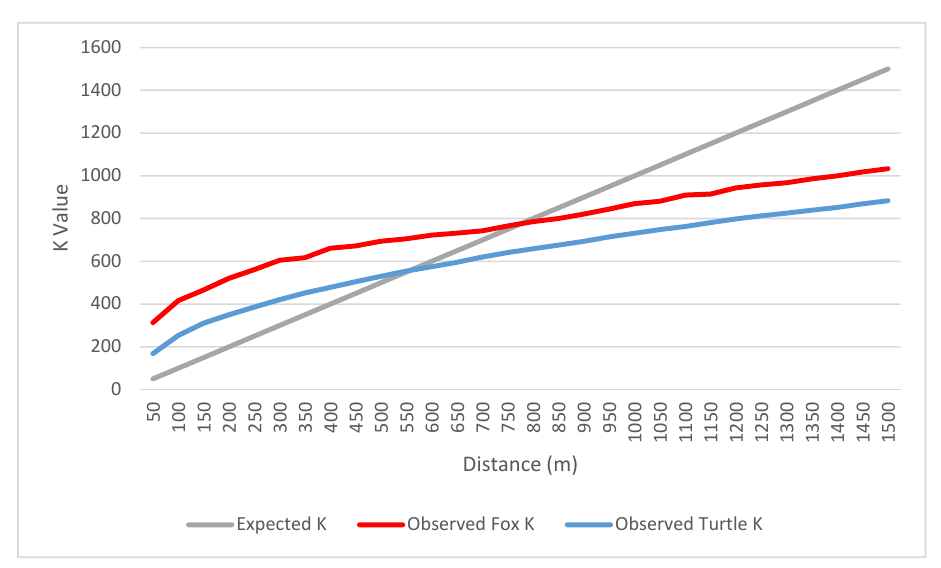
Figure 3. Ripley K spatially clustering of fox den entrances and sea turtle nests at distances between 50 m and 600 m (fox) and 50 m and 400 m (sea turtles). At larger distances, the locations are dispersed across the entire study area.